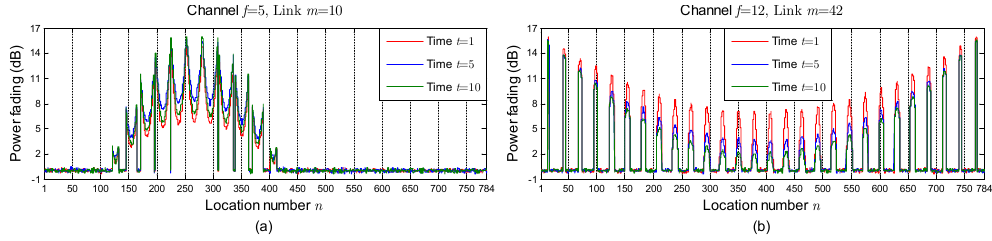
Figure 8. The values of the dictionary atoms: ( a ) φ . 5